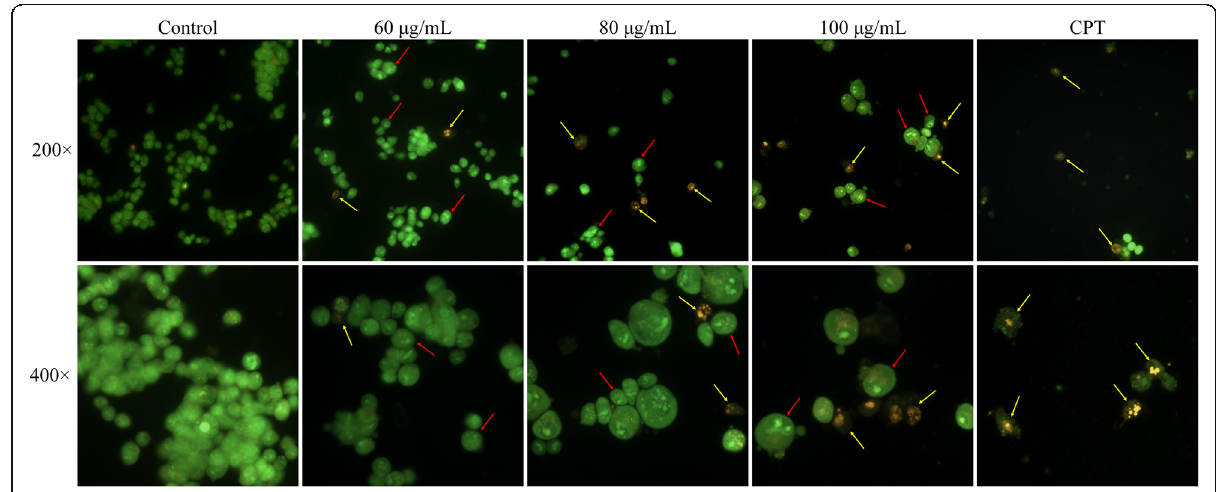
Fig. 3 Apoptotic characteristics of HepG2 cells were observed via AO-EB dual staining. Cells were incubated with AP-XS extract at variety of concentrations and Camptothecin (CPT) for 60 h. Some characteristics are expressed as condensation and fragmentation of chromatins (red arrows) and late apoptotic cells (yellow